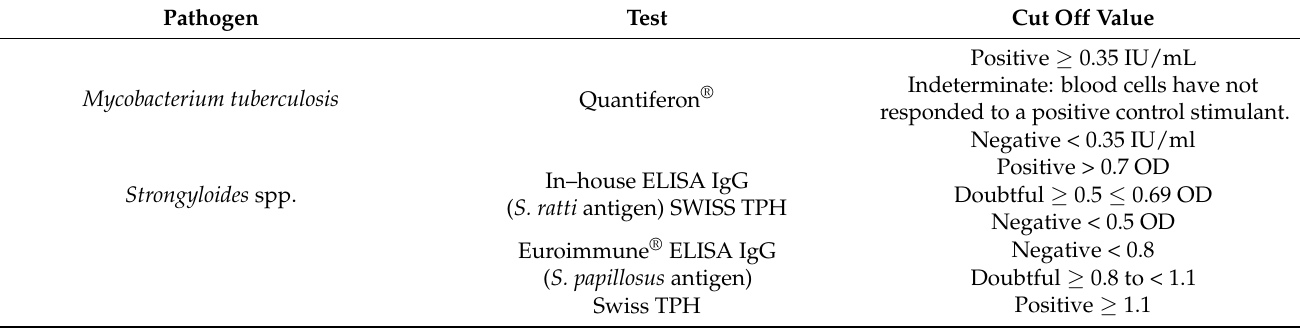
Table 1. Screening test type and cut